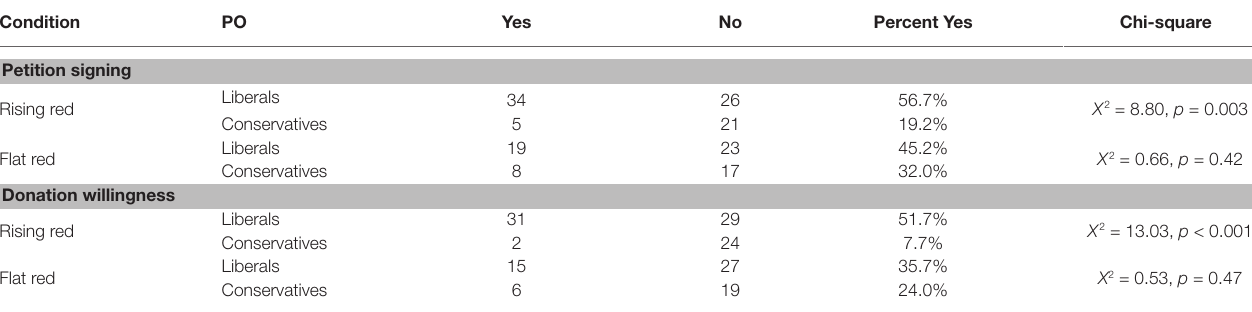
TABLE 2 | The number of liberals and conservatives who signed the petition or were willing to donate in the rising red and the flat red conditions. Condition PO Yes No Percent Yes